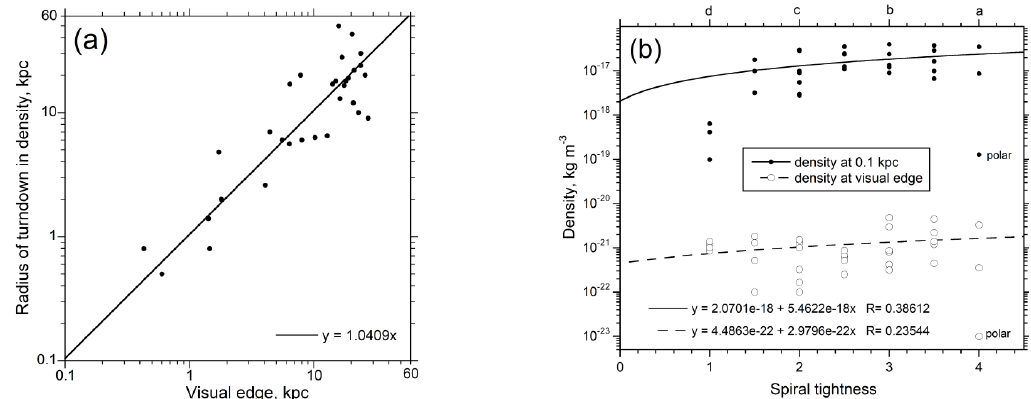
Figure 10. Density trends in spiral galaxies: ( a ) Radius of the turndown in density on the position of 0.1 kpc. Density at 0.1 kpc strongly increases with the size of both spiral and elliptical galaxies (Figure 9a,b). The slopes of the regression lines for these types are similar, despite the disparity in the number of samples (36 spirals vs. 4 ellipticals), and disparities in central density between ellipticals and spirals. The three lenticular and eight dwarf galaxies measured also fall on or near these trends. The polar-ring type is less dense, due to its shape, with considerable matter out of the plane. Notably, the smallest galaxies, the dwarf spheroidals, have densities near the crossing of the trends and show little variation in ρ with r . Interestingly, increasing tightness of the spiral arms is associated with higher ρ at 0.1 kpc (Figure 10b). This finding is consistent with spiral arms being concentrations of stars.